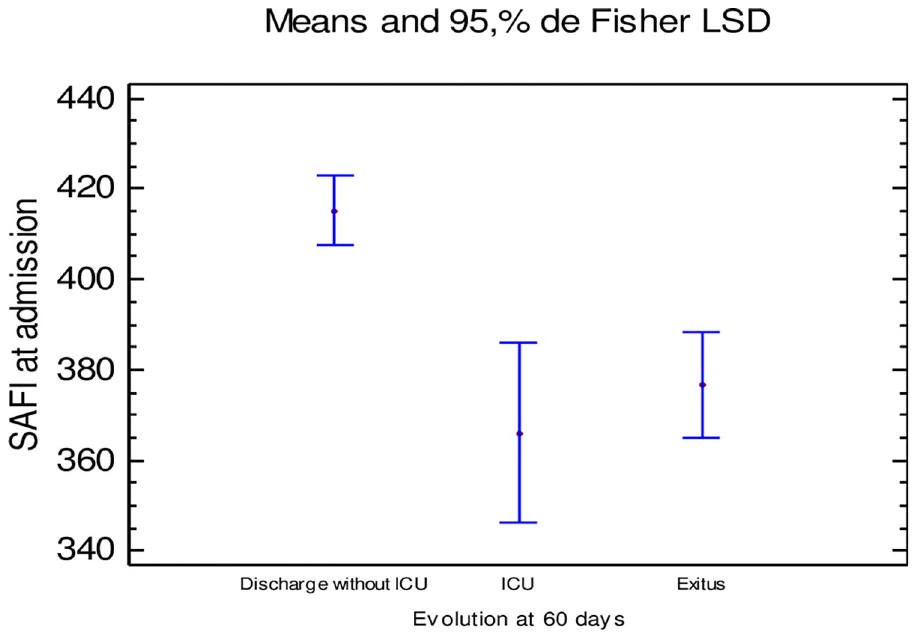
Fig 2. Relationship between mean SaFi at admission and clinical outcome at 60